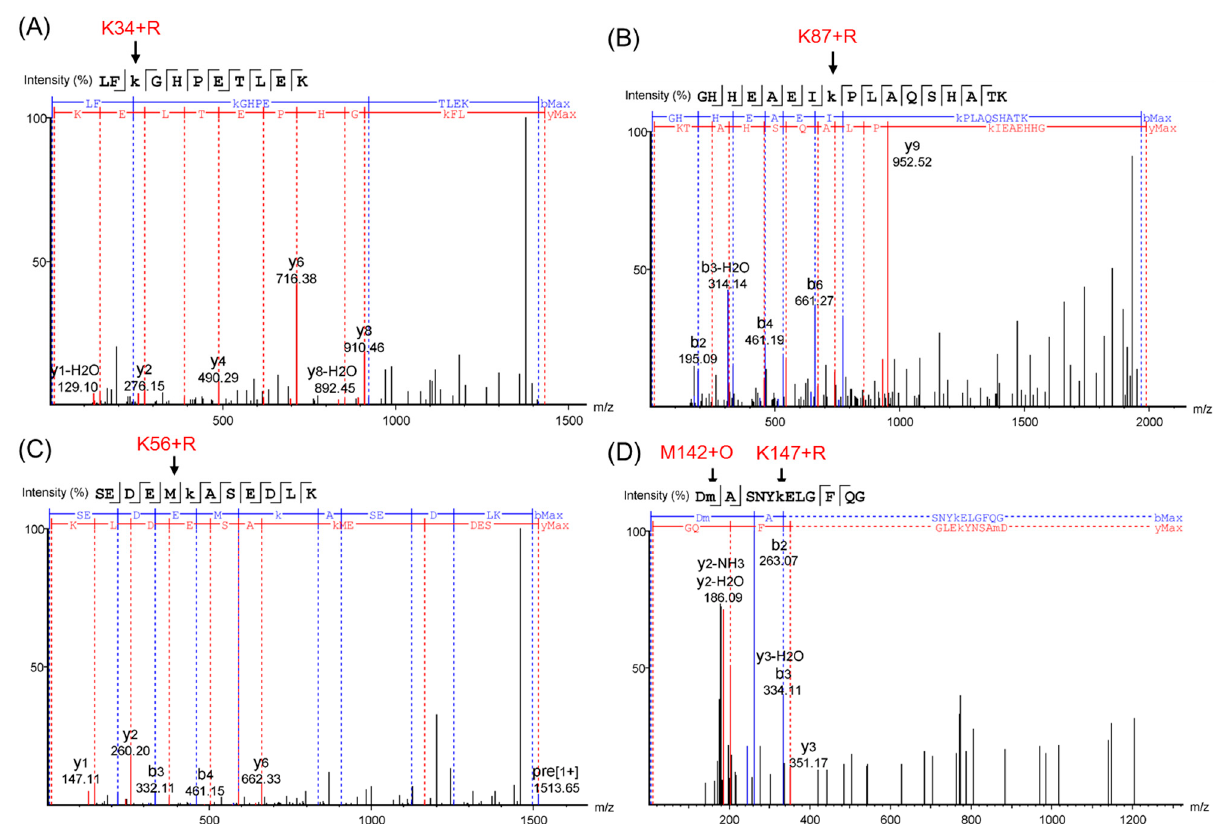
Figure 5. ESI-MS/MS spectra of peptide fragments: The triply protonated tryptic glycosylated HMb peptide LFK(+132.04)GHPETLEK at m / z 477.58 ( A ); the triply protonated tryptic glycosylated HMb peptide GHHEAEIK(+132.04)PLAQSHATK at m / z 662.67 ( B ); the doubly protonated tryptic glycosylated HMb peptide SEDEMK(+132.04)ASEDLK at m / z 757.33 ( C ); and the triply protonated tryptic glycosylated HMb peptide DM(+15.99)ASNYK(+132.04)ELGFQG at m / z 804.35 ( D ), respectively. The glycation sites of the Lys and the oxidation of the Met142 are indicated by arrows.